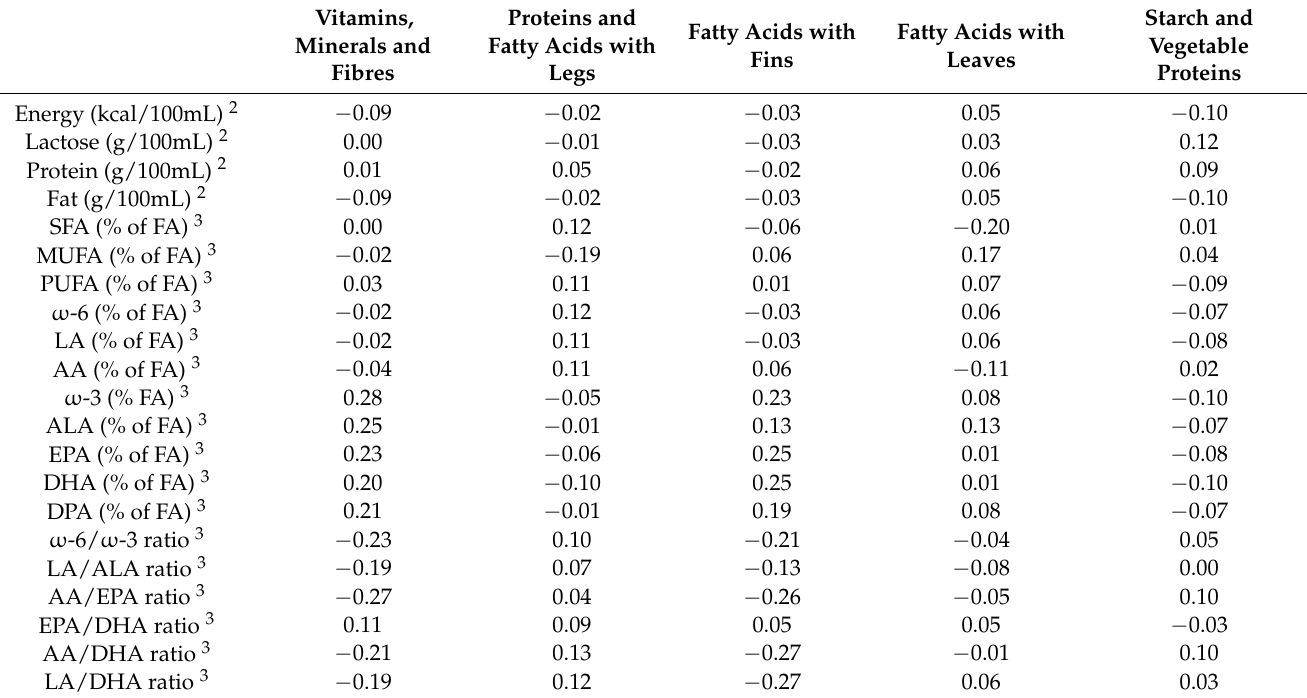
Table 3. Pearson’s correlation coefficients 1 between human milk components and continuous factor scores of the five maternal dietary patterns identified in the MEDIDIET study, using principal component factor analysis (PCFA). Starch and Proteins and Vitamins, Fatty Acids with Fatty Acids with Vegetable Fatty Acids with Minerals and Fins Leaves Proteins Legs Fibres Energy (kcal/100mL) 2 − 0.09 − 0.02 − 0.03 0.05 − 0.10